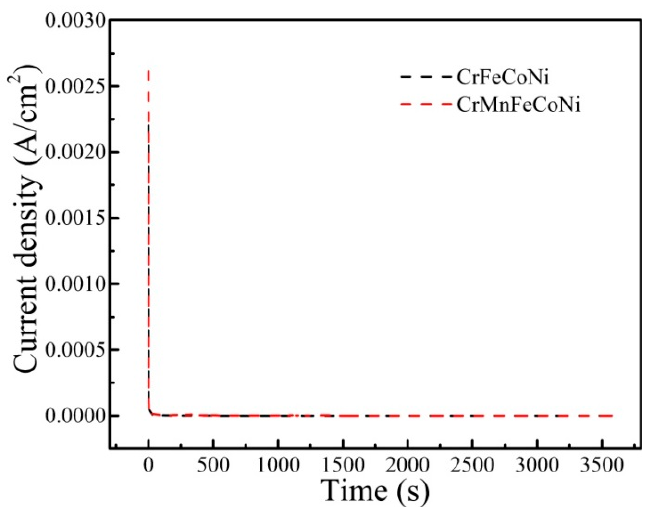
Figure 6. Current-time transient curves of the CrFeCoNi and CrMnFeCoNi coatings at applied voltage of -0.1 V SCE for 2 h in 3.5 wt% NaCl solution.